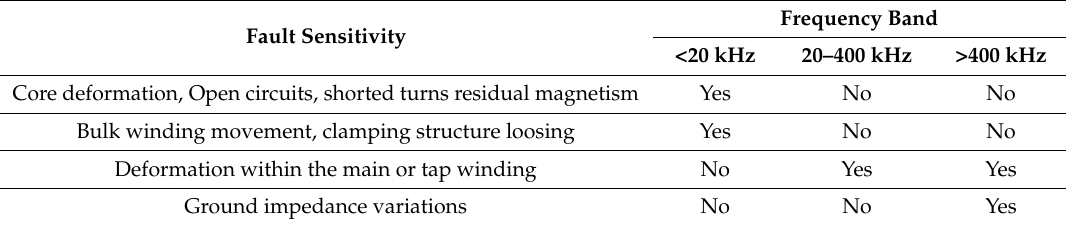
Table 1. Frequency response analysis (FRA) bands and their sensitivity to different